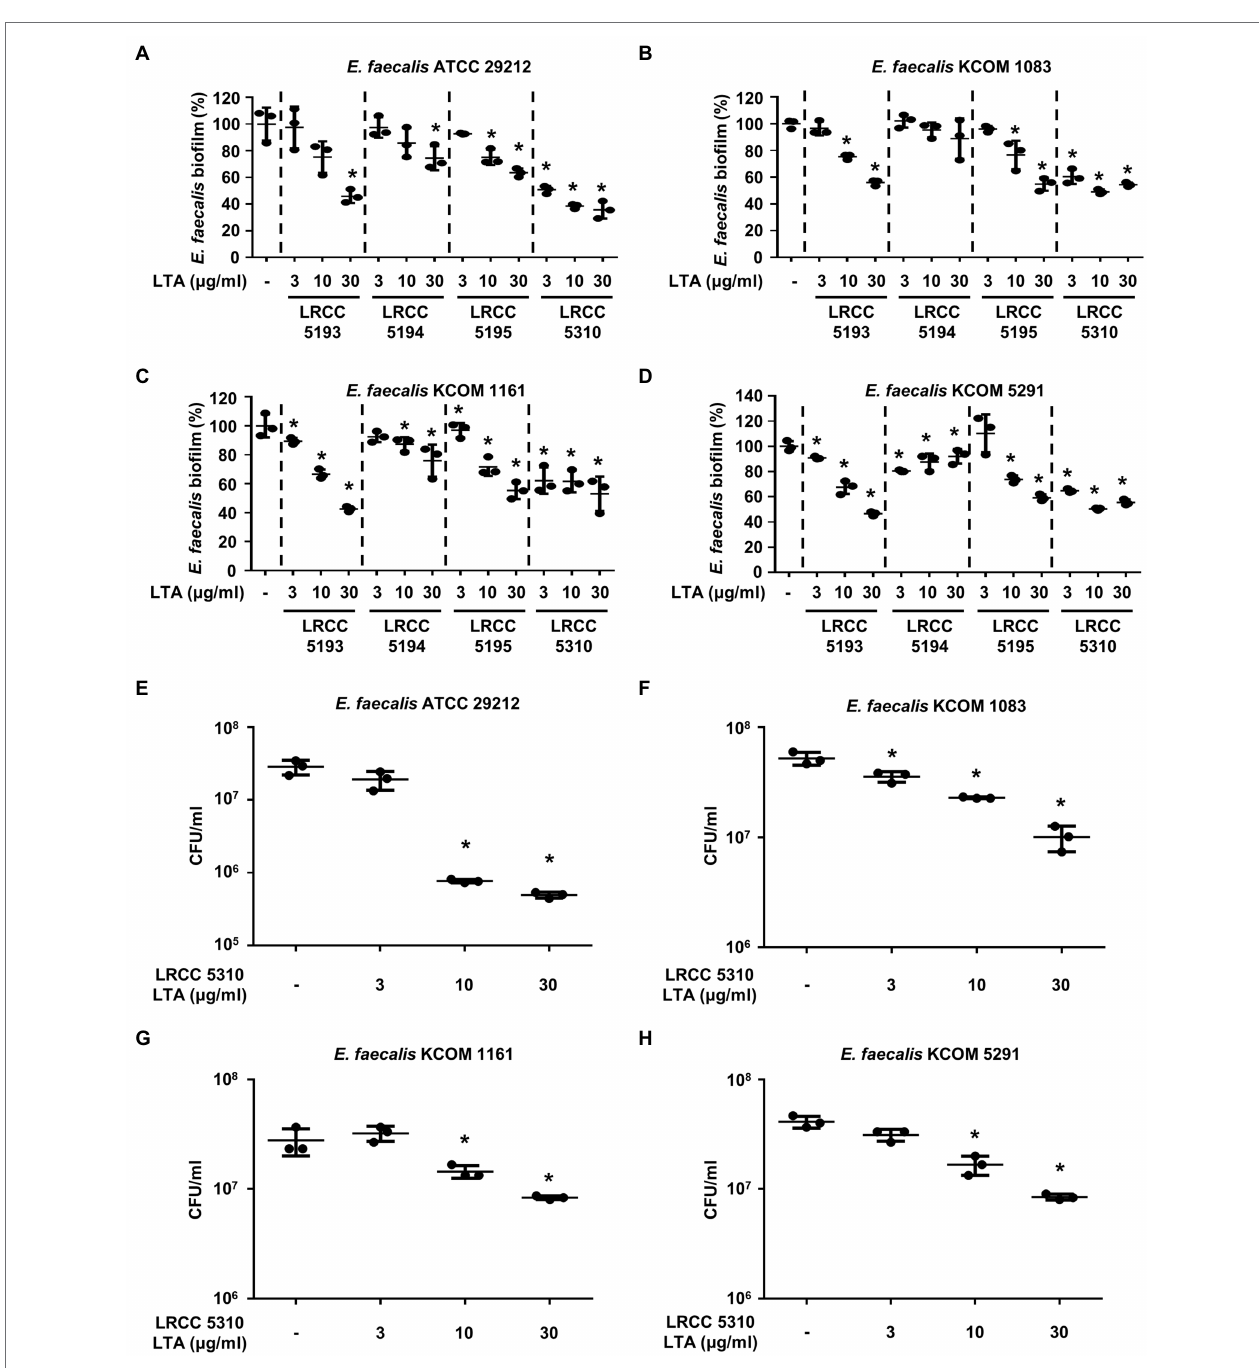
FIGURE 2 | Lp.LTAs dose-dependently inhibit E. faecalis biofilm formation. Four strains of E. faecalis , including (A,E) a laboratory (ATCC 29212) and (B–D,F–H) three clinically isolated strains (KCOM 1083, KCOM 1161, and KCOM 5291), at 1 × 10 7 CFU/ml were grown on 96-well plates in the presence or absence of the indicated concentrations of (A–D) various Lp.LTA or (E–H) LRCC 5310 Lp.LTA at 37 ° C for 24 h. After the incubation, biofilm formations were determined by crystal violet staining as described in Materials and Methods. Biofilm formation is presented as percentage change ± standard deviation of triplicates against the non- treatment group set as 100%. (E–H) After collecting the biofilm, it was serially diluted and incubated on the THY agar plate at 37 ° C for 48 h, and CFU formation was examined. Asterisk (*) indicates statistical significance at p < 0.05 between the non-treatment and each Lp.LTA treatment